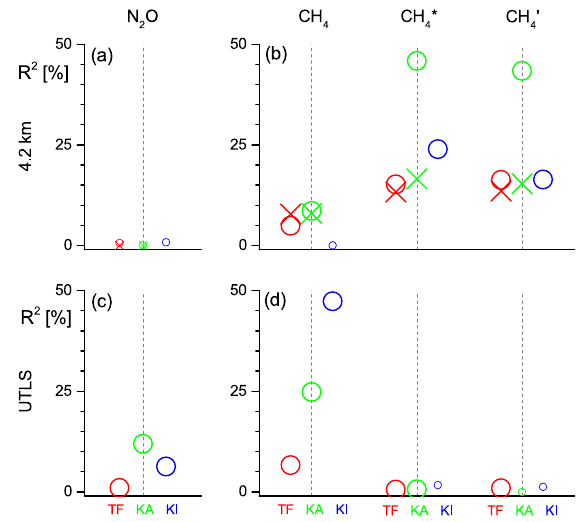
Figure 19. Correlation coefficients R 2 between the MUSICA IASI and reference intra-month day-to-day variations ( d(t) of Eq. 21): (a) and (b) for 4.2km retrieval altitudes; (c) and (d) for altitudes representing the UTLS region; (a) and (c) for N 2 O; and (b) and (d) for CH 4 , CH ∗ and CH (cid:48) . A description of the CH ∗ 4 4 4 and CH (cid:48) products is given in Table 2. The crosses are for correla- 4 tions with GAW high-mountain observatory in situ references and the circles for correlations with NDACC FTIR references. Large symbols indicate significant positive correlations (95% confidence level) and small symbols indicate no significance. Red, green and blue colour for analyses in the surroundings of Tenerife Island (TF), Karlsruhe (KA) and Kiruna (KI),